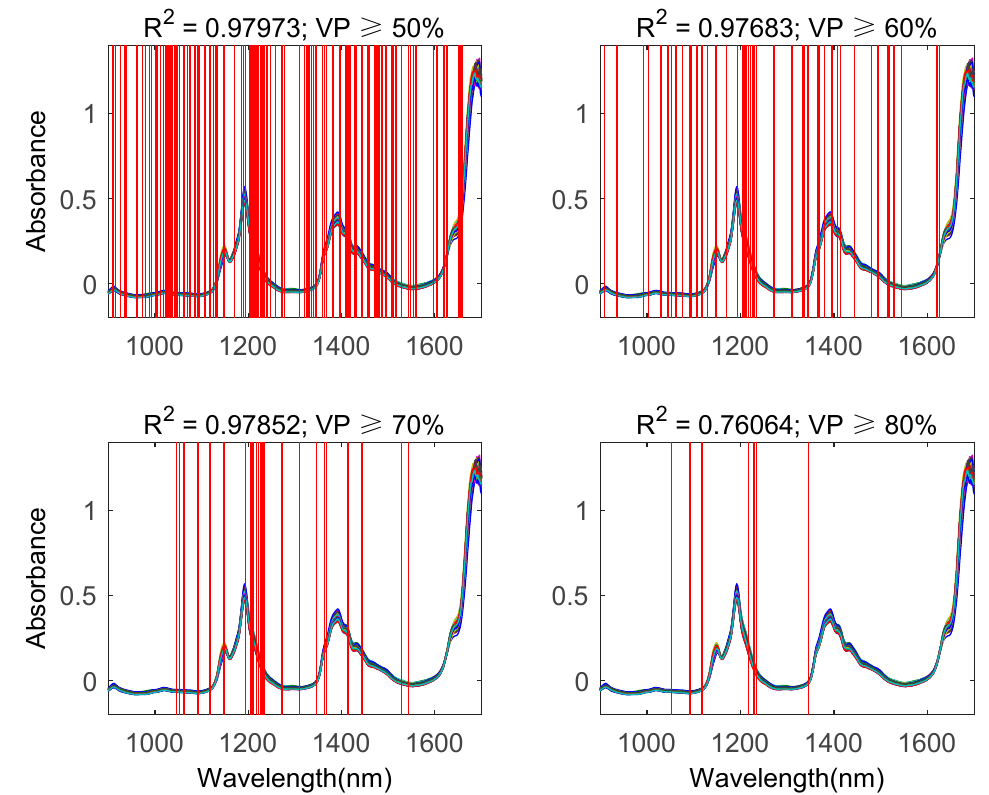
Figure 7. Wavelength selection results by using the BDA and ensemble learning method. VP: votes percentage. Upper left, upper right, lower left, and lower right represent selected wavelengths with votes percentage equal to or greater than 50%, 60%, 70%, and 80%, respectively.